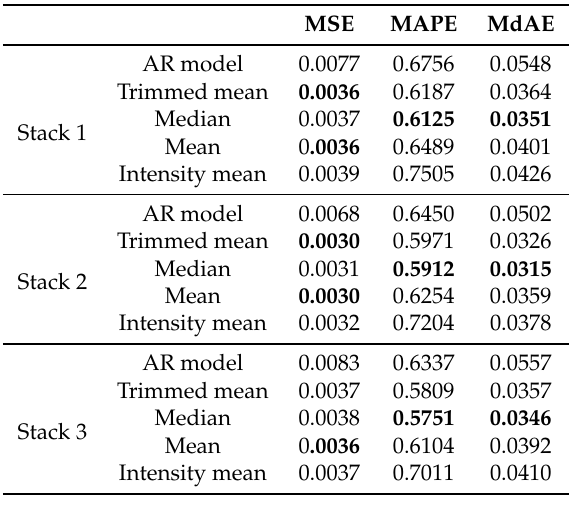
Table 2. Measures of quality of the ground scene prediction image. The interest image in Stacks 1, 2 and 3 is the image of mission 1 and passes 1, 2 and 5, respectively. We highlighted the values of each quality adjustment measure that yielded the smallest